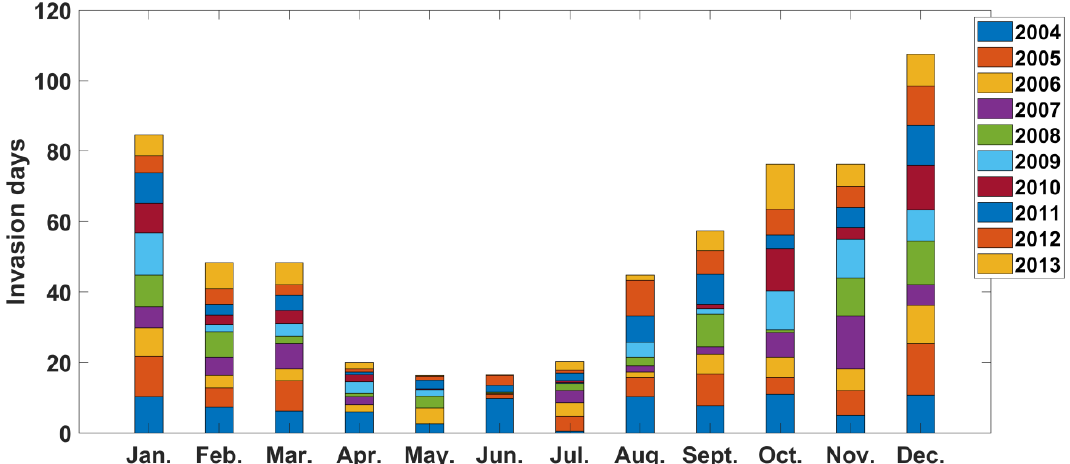
Figure 2. The number of days affected by strong northward winds (over 17.2 m/s) in the ECS in each month during 2004–2013.